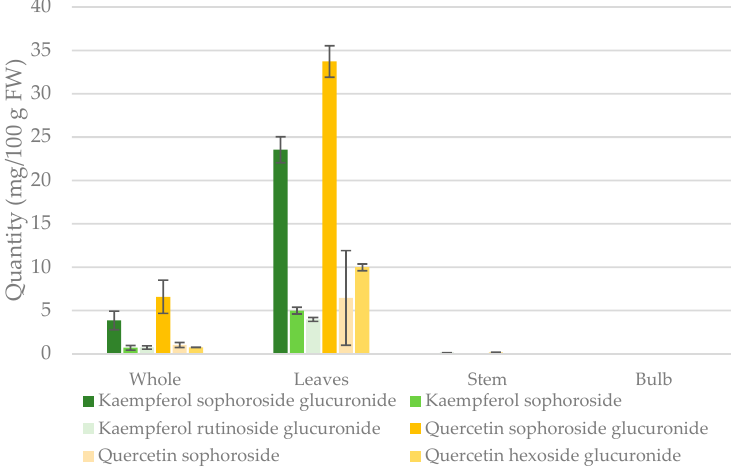
Figure 4. Estimated contents of the major flavonol glycosides identified in whole ramps and separate organs using UHPLC-PDA. Standard deviation bars are shown for n = 3. Quantities reported as mg/100g fresh weight (FW).